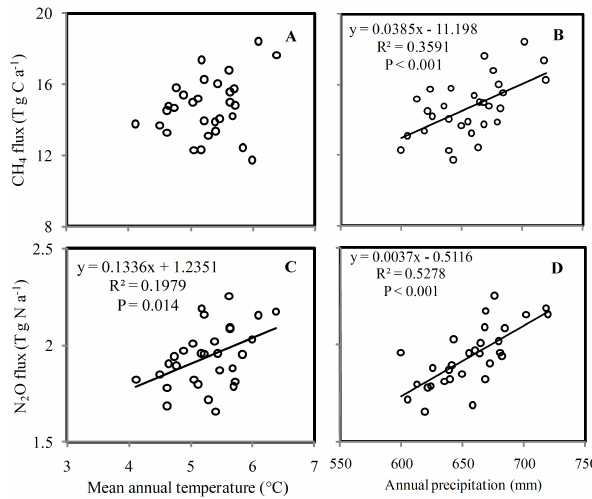
Fig. 9. Correlation between annual CH 4 and N 2 O fluxes and mean annual temperature and annual precipitation – (A) Correlation be- tween CH 4 flux and mean annual temperature; (B) Correlation be- tween CH 4 flux and annual precipitation; (C) Correlation between N 2 O flux and mean annual temperature; (D) Correlation between N 2 O flux and annual